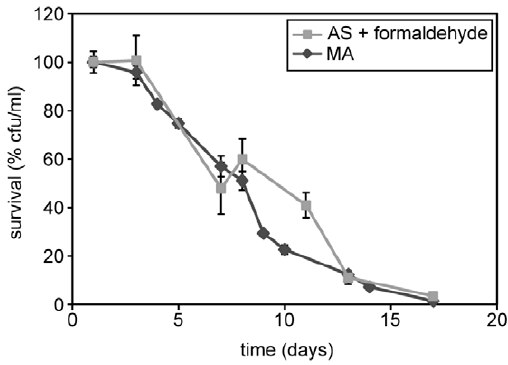
Figure 8. Formaldehyde extends the CLS. Wild-type cells were grown on methanol media containing 0.25% ammonium sulphate or 0.25% MA. Upon reaching the stationary phase, the ammonium sulphate containing culture was supplemented with 37.8 mM formal- dehyde. The MA cultures were kept in the same medium as a control. Bars indicate the standard error of mean of 2 experiments.